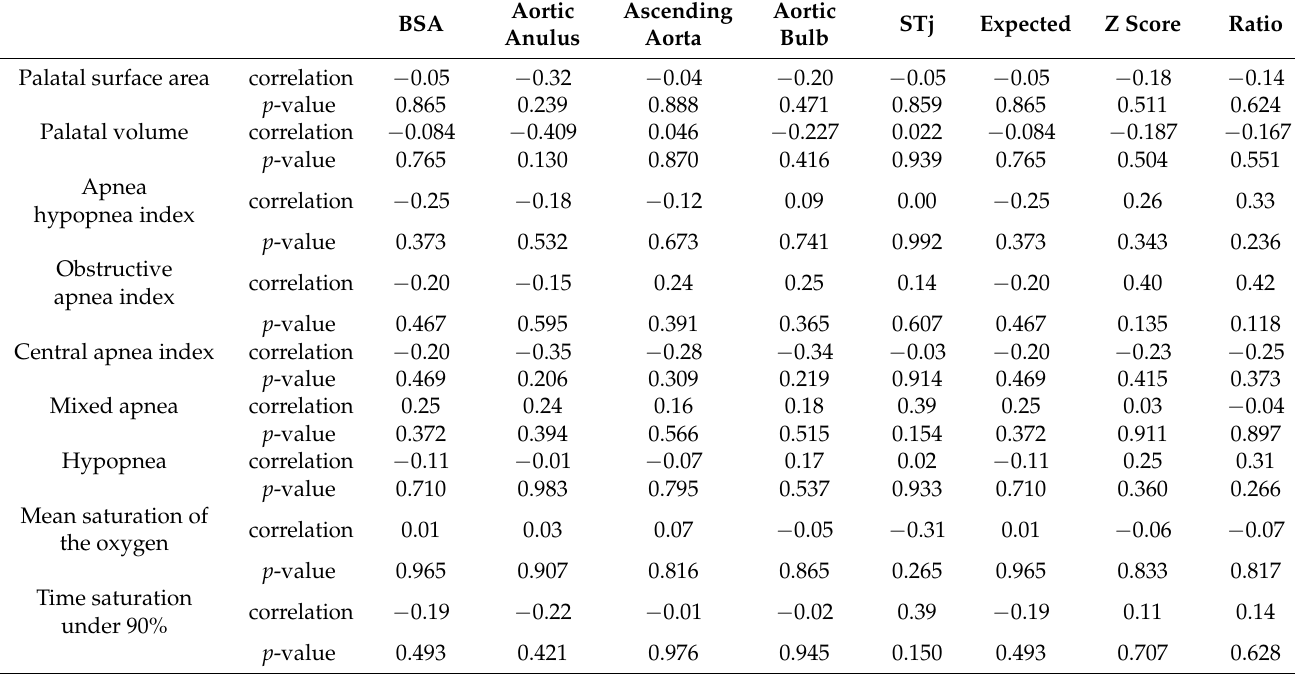
Table 6. Correlation analysis of the Marfan syndrome group between palatal morphology and cardiorespiratory monitoring index and echocardiography-derived sizes in the study